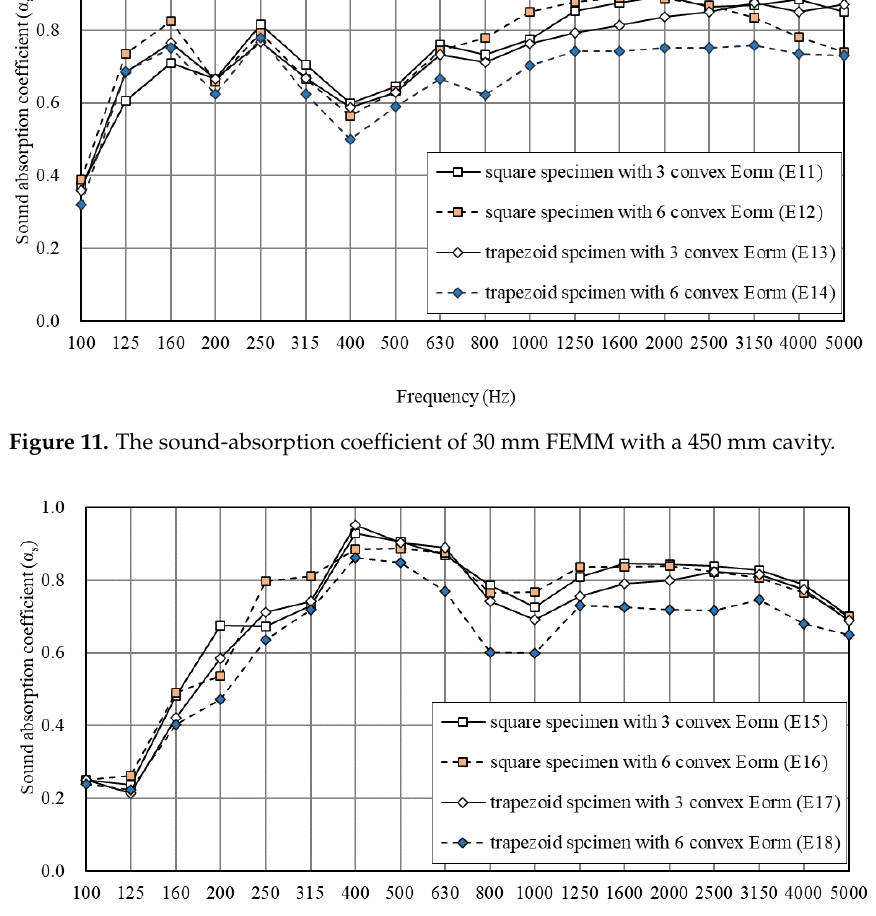
Figure 10. The sound-absorption coefficient of 80 mm FEMM with a 200 mm cavity.